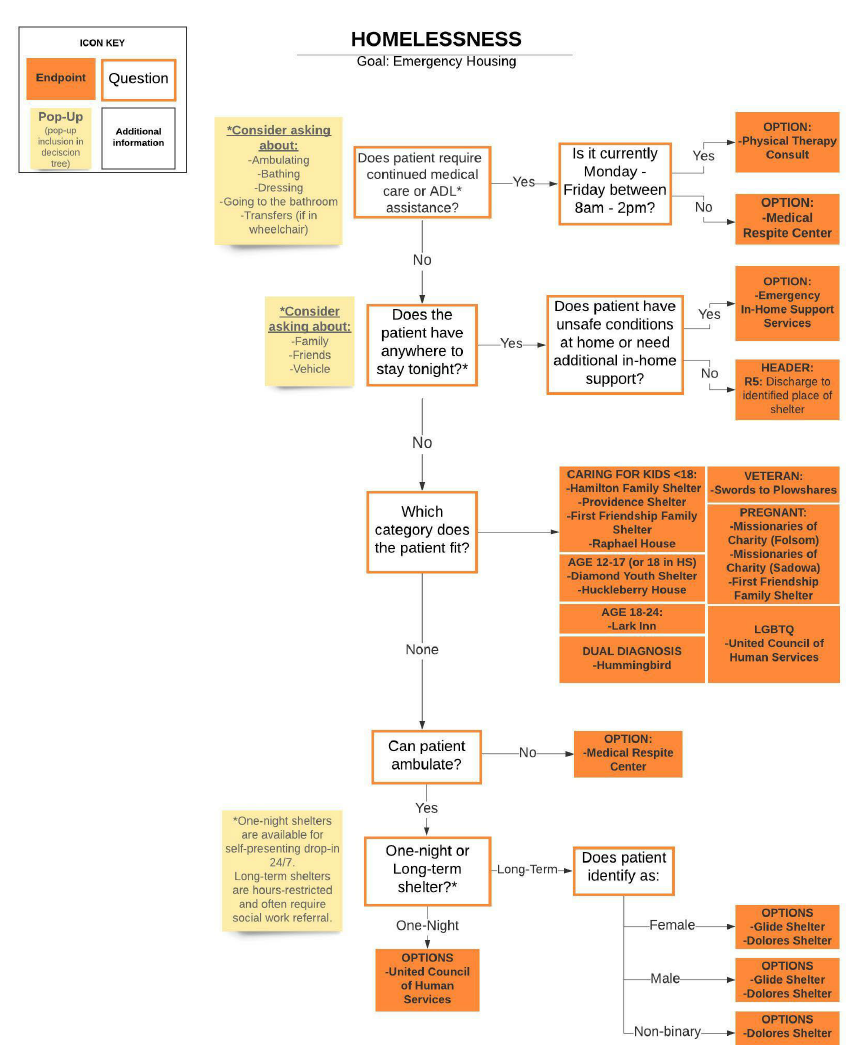
Figure 1. Decision tree for community resources to address homelessness, based on patient